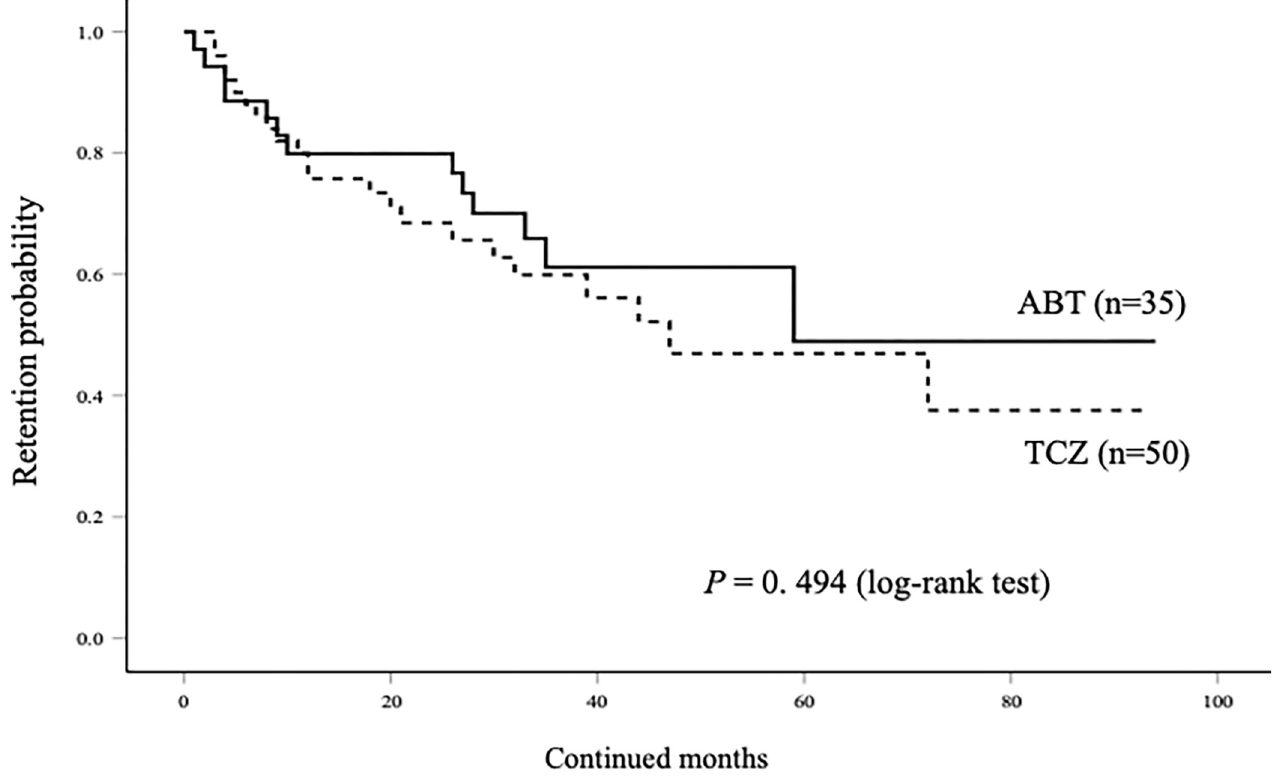
Fig 8. Kaplan–Meier curve related to the overall cumulative drug retention rate of ABT and TCZ in EORA (more than 60 years) patients initiating these bDMARDs. There was no significant between-group difference with respect to the drug retention rates.